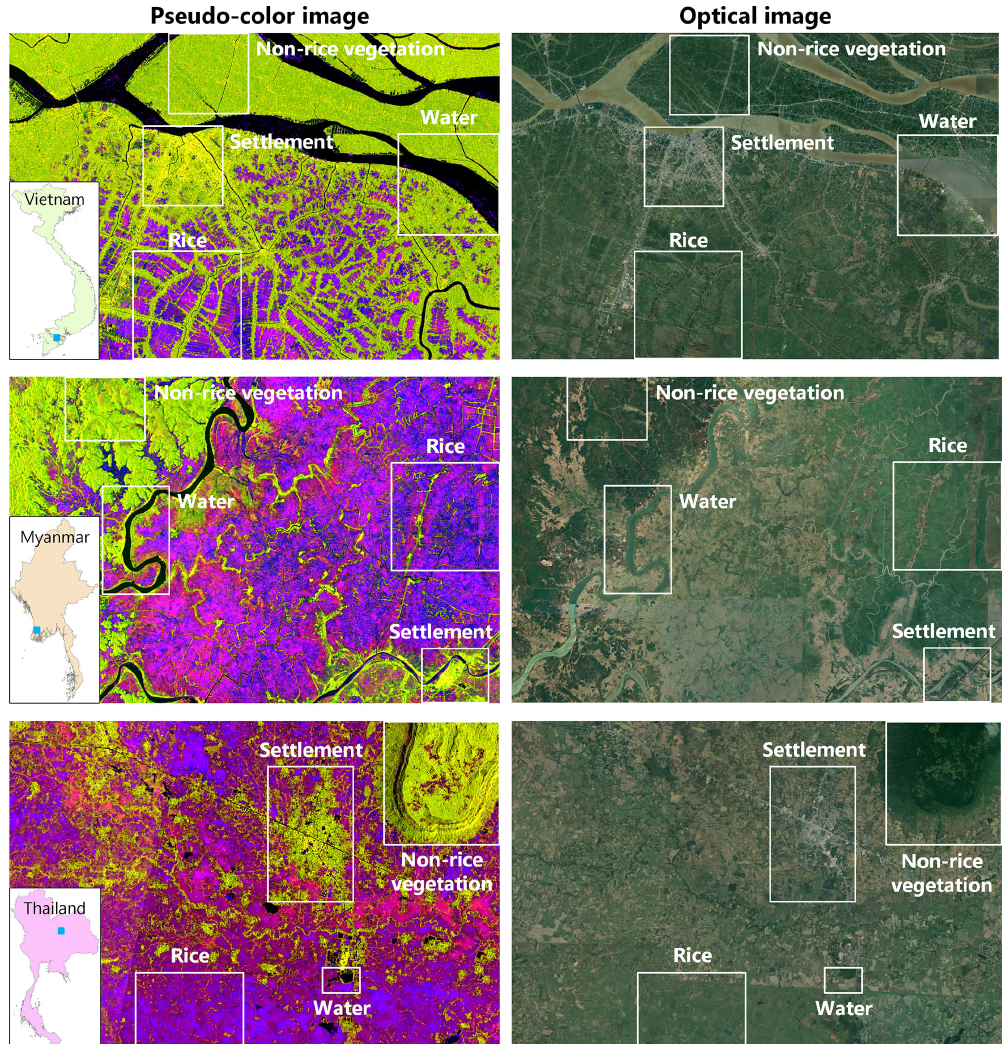
; B : σ 0 var ) and the corresponding optical min